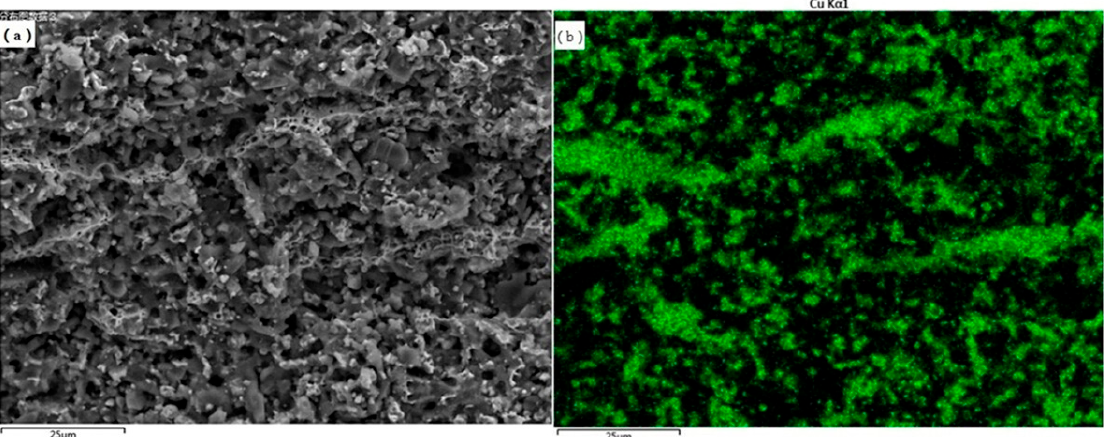
Figure 6. Cu distribution in the fracture surface of Al 2 O 3 /30glass/30Cu f substrate parallel to the pressure direction: ( a ) Microstructure; ( b ) Distribution of Cu element marked by green.